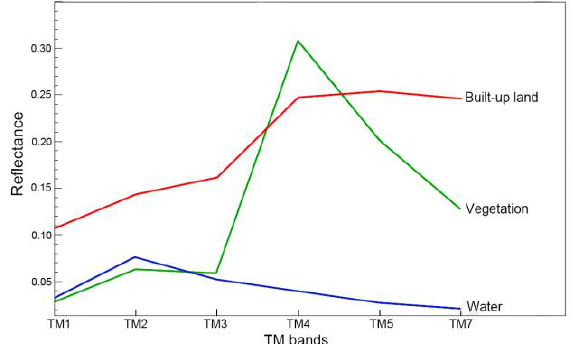
Figure 3. The spectrum extracted from pure pixel samples of built-up land, vegetation and water in the study area, showing the reflection characteristics of different bands on typical